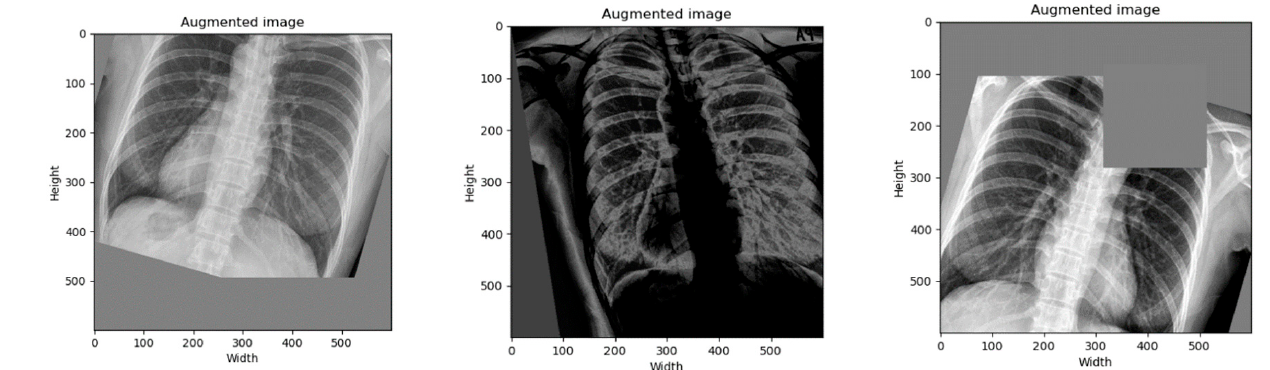
Figure 4. Augmented images were generated randomly using the RandAugment technique.